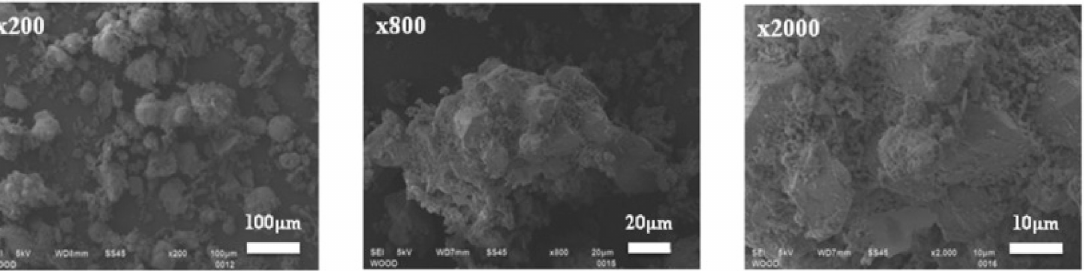
Figure 8. SEM image of WWA (Grau et al., 2015) (Used from an open source journal of MDPI